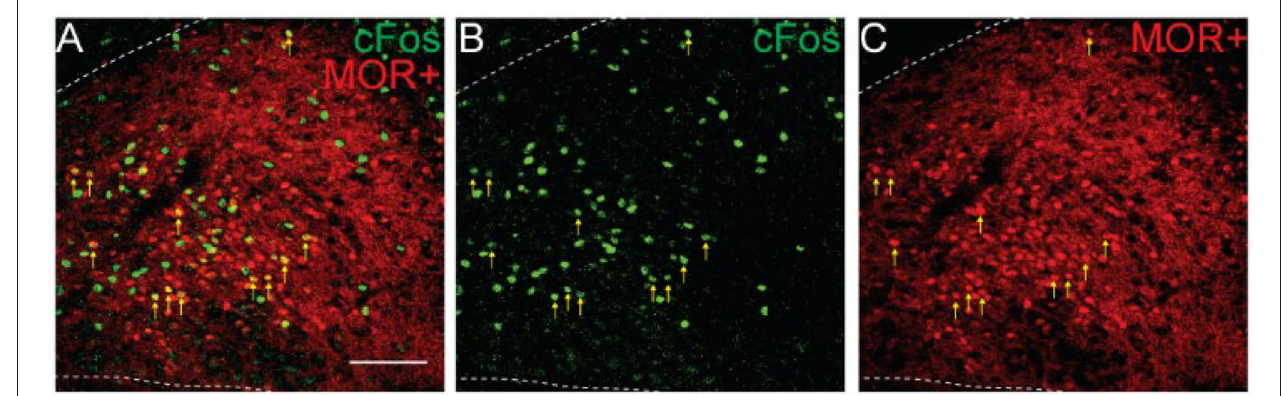
FIGURE 5 | Morphine induces cFos expression in MOR-positive and MOR-negative NTS neurons. Identification of cFos immunolabeling and tdTomato expression, as an indicator of MOR expression, in the NTS of Oprm1 Cre / tdT mice that were injected with morphine (30 mg/kg). (A–C) Example images of cFos immunostaining (green) and MOR + tdTomato expression (red). Scale bar = 100 µ m. Cells that co-expressed cFos and tdTomato are indicated by yellow vertical